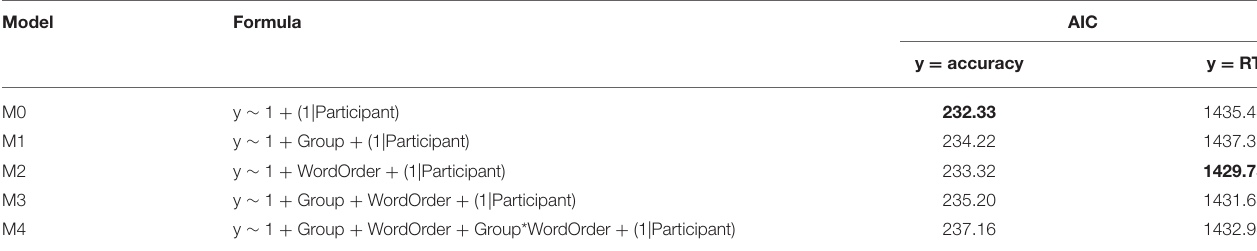
TABLE 6 | Model space for accuracy and RTs in the comprehension task. Model